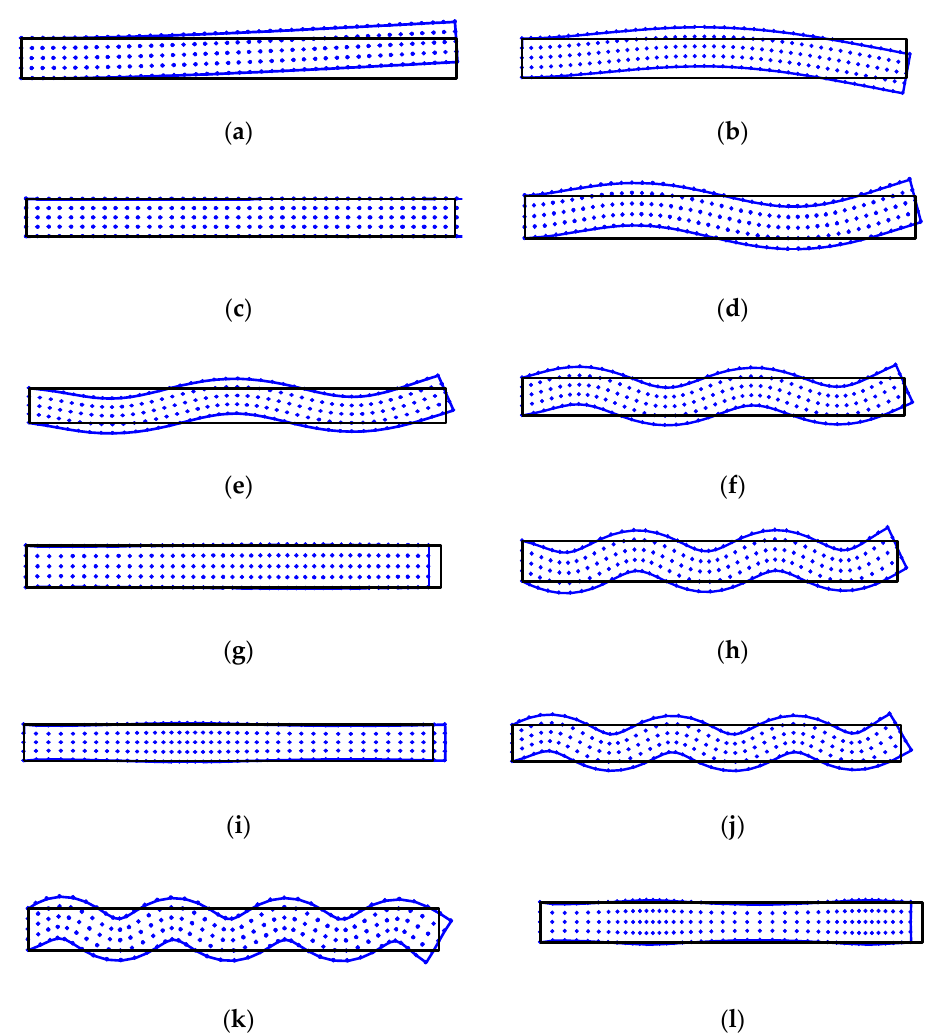
Figure 4. The free vibration modes of cantilever beam corresponding to the first twelve natural frequency values from the present M-RPIM: ( a ) Mode 1; ( b ) Mode 2; ( c ) Mode 3; ( d ) Mode 4; ( e ) Mode 5; ( f ) Mode 6; ( g ) Mode 7; ( h ) Mode 8; ( i ) Mode 9; ( j ) Mode 10; ( k ) Mode 11; ( l ) Mode 12.